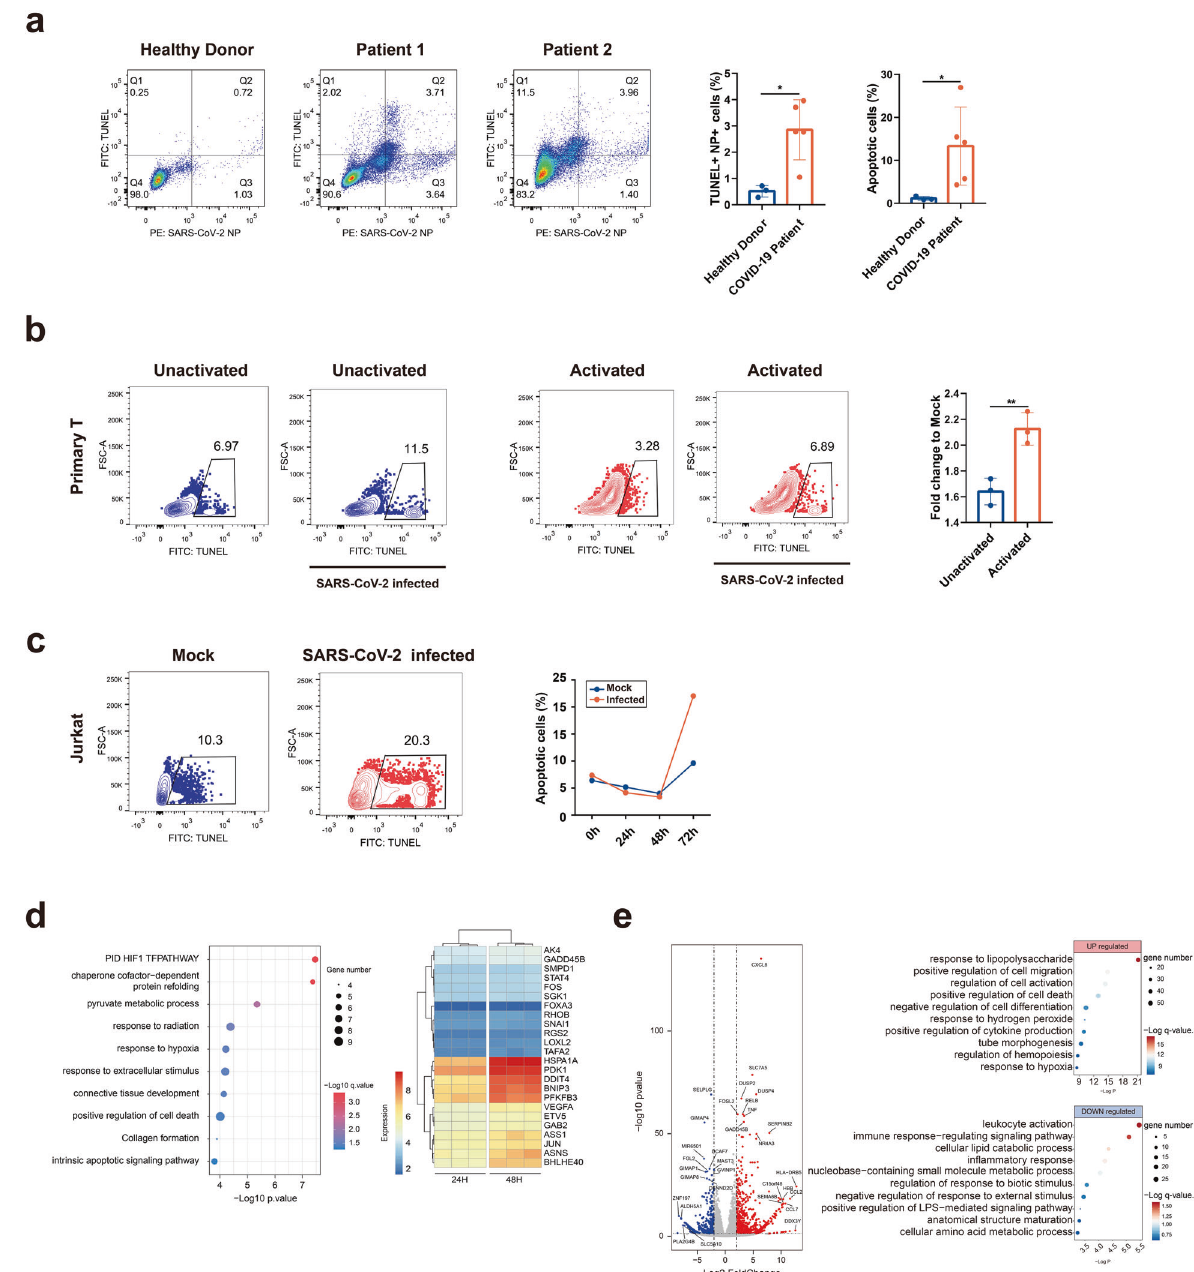
Fig. 4 SARS-CoV-2 infection-induced apoptosis in T cells. a Detection of apoptotic T lymphocytes in human PBCs. PBCs were prepared from COVID-19 patients or from healthy donors. Apoptosis in virally infected T lymphocytes were determined using CD3, SARS-CoV-2 NP antibodies, and TUNEL assay. Detection results for two patients and one healthy donor, or the statistics of apoptotic cells or TUNEL/NP double- positive cells were shown for healthy donors (H, n = 3) or patients (P, n = 5). Comparison of mean values between two groups was analyzed by Student ’ s t test. * P < 0.05. b Unactivated or activated primary T cells were infected with SARS-CoV-2 (MOI = 0.01) for 8 h and cell apoptosis was analyzed with TUNEL assay. ** P < 0.01. c Activated Jurkat cells were infected with SARS-CoV-2 (MOI = 0.01) for 0, 24, 48, and 72 h. The ratio of apoptotic cells in 72 h mock or SARS-CoV-2-infected cells were shown ( fl ow chart). The ratio of apoptotic cells in different time points were also compared (plot). d Samples from C were subjected for RNA-seq analysis. The top ten upregulated GO pathways in 48 h compared to 24 h group are shown. Heatmap shows the normalized expression of genes that were enriched from PID HIF1 pathway. The data were analyzed by Student ’ s t test (* P < 0.05; ** P < 0.01; NS no signi fi cance). e Compared to healthy donors, differentially e xpressed genes of severe COVID-19 patients were shown in the volcano plot, and the top ten differential expressed pathways were shown in the right panel